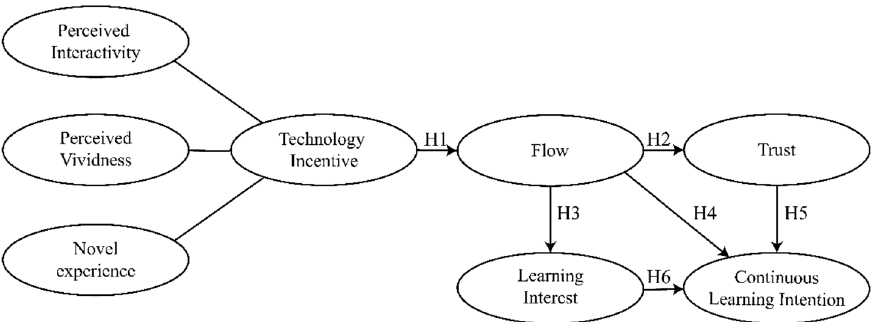
Figure 1. Hypothesis of the